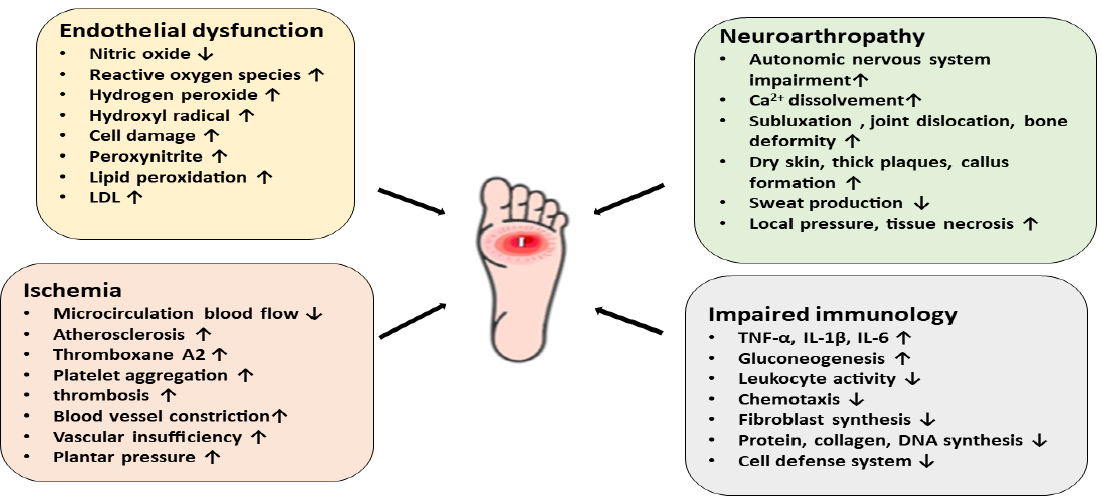
Figure 5. A schematic diagram representing the pathophysiology of diabetic foot ulcers via different mechanistic pathways. Endothelial dysfunction, ischemia, neuroarthropathy, and impaired immunology contribute to the pathophysiology of DFU.